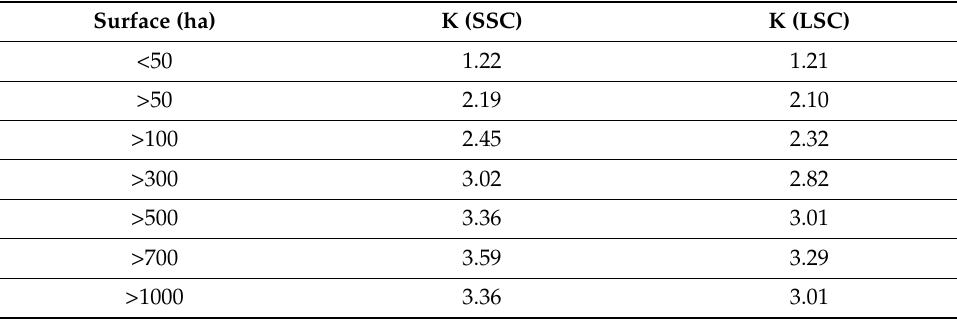
Table 2. Average rugosity of entities constituting beef feeding